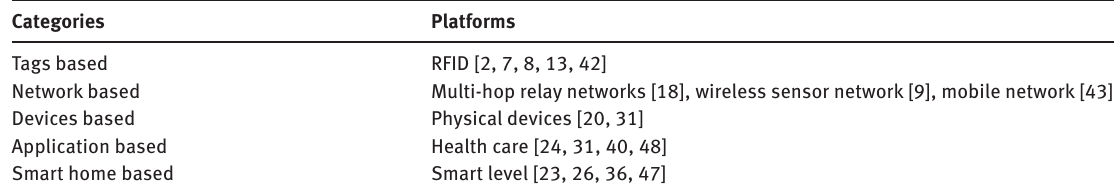
Table 3: Analysis Based on Application.